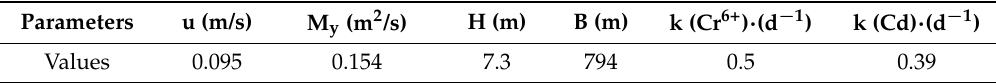
Table 1. Selected values of parameters in water quality